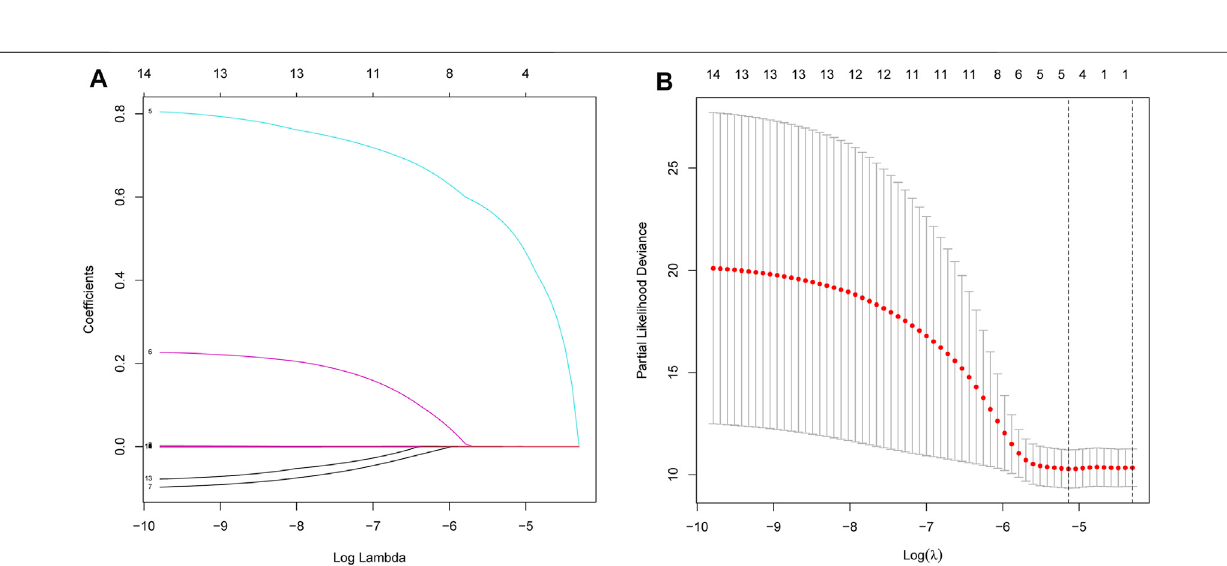
FIGURE 2 | Processes of LASSO Cox model fi tting. (A) . Pro fi les of coef fi cients in the model at varying levels of penalization were plotted against the log(lambda) sequence. (B) . Ten-fold cross-validated error (the fi rst and second vertical lines denote the minimum and cross-validated errors, respectively, within 1 standard error of the